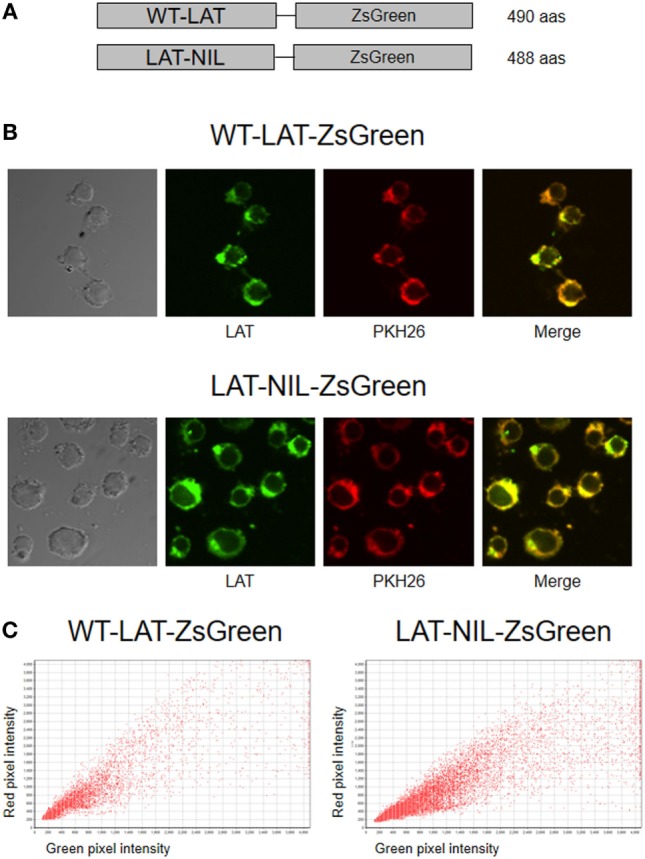
Subcellular localization of LAT-NIL protein. (A) Schematic representation of WT-LAT-ZsGreen and LAT-NIL-ZsGreen fusion proteins lentivirally transduced into J.CaM2 cells. (B) J.CaM2 cells lentivirally transduced with DNA coding for the fusion proteins of WT-LAT or the LAT-NIL mutant were labeled with 2 µM PKH26 red fluorescent dye, and examined with confocal microscopy. Images were captured at 60× magnification. Images on the right show merged green and red fluorescence. (C) Scatterplots of green and red pixel intensities of cells shown in (B).